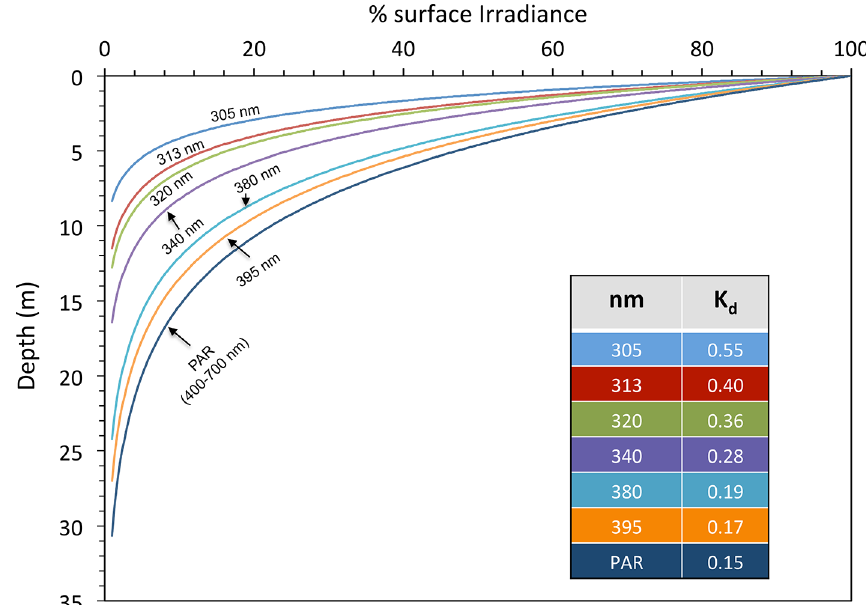
Fig 2. Vertical profile of solar radiation penetration and attenuation coefficients (K d in m -1 ) for different wavelengths of UV-B and UV-A radiation and PAR band (400 – 700 nm). Values represent average of a representative sunny day at mid-summer (January 2013) at Fildes